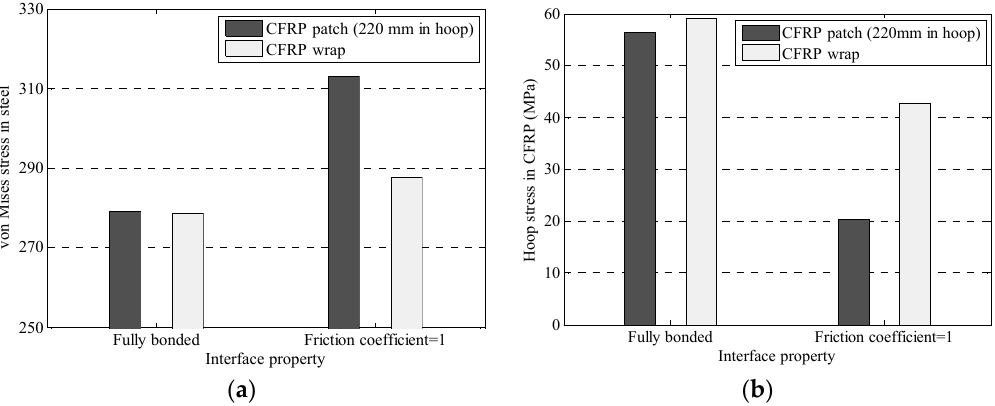
Figure 12. Effect of interface property on ( a ) von Mises stress in pipe and ( b ) hoop stress in CFRP.